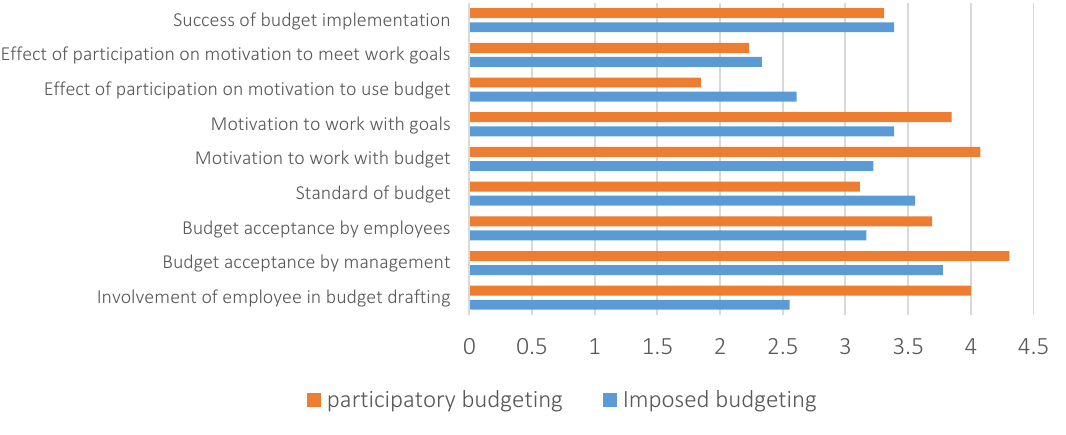
Figure 3. Budgeting style and employee motivation on a five-point Likert scale